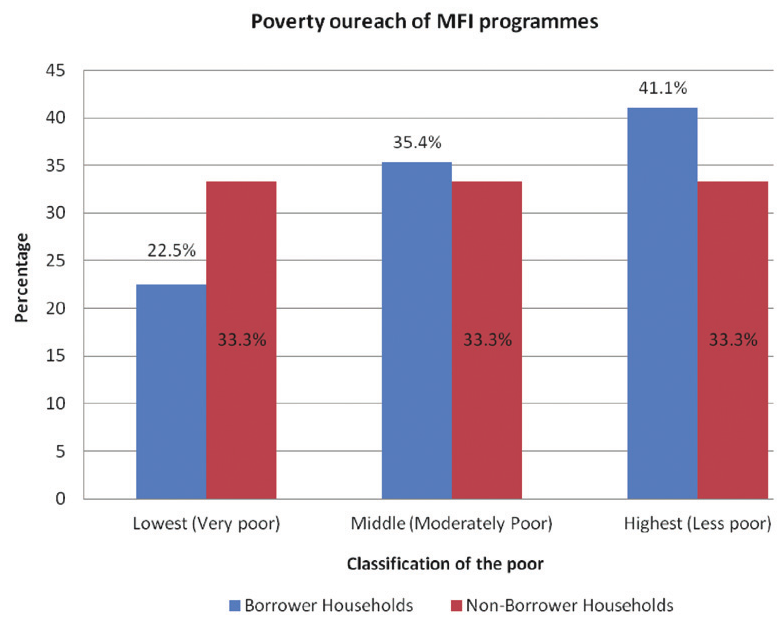
Fig. 3. Distribution of borrowers and non-borrowers amongst the relative